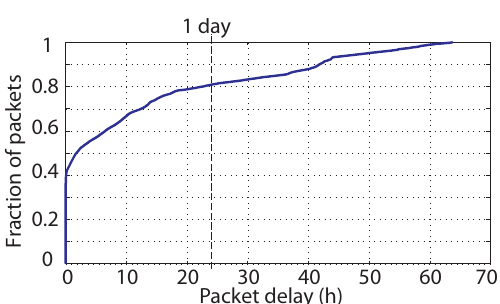
at 10, 20, 30, 50 and 100 cm; whereas at location M2, dif-